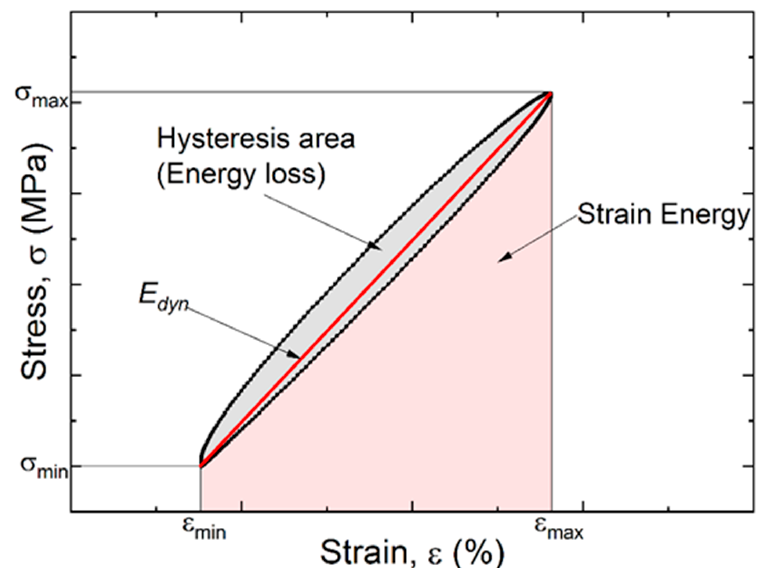
Figure 3. A schematic representation of the mechanical hysteresis loop and its parameters.